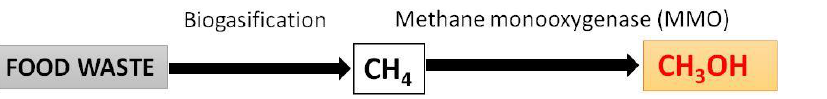
Figure 15. Oxidation of methane generated from food waste to methanol by methane mono-oxygenase.